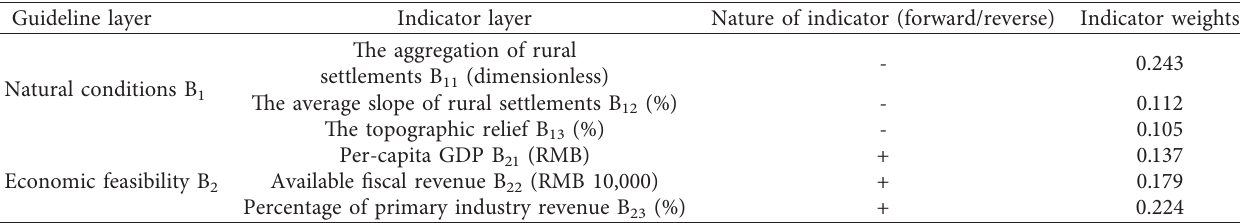
Table 6: Determination of rural residential land consolidation actual potential correction factor evaluation index system weights con- sidering natural conditions and economic feasibility.